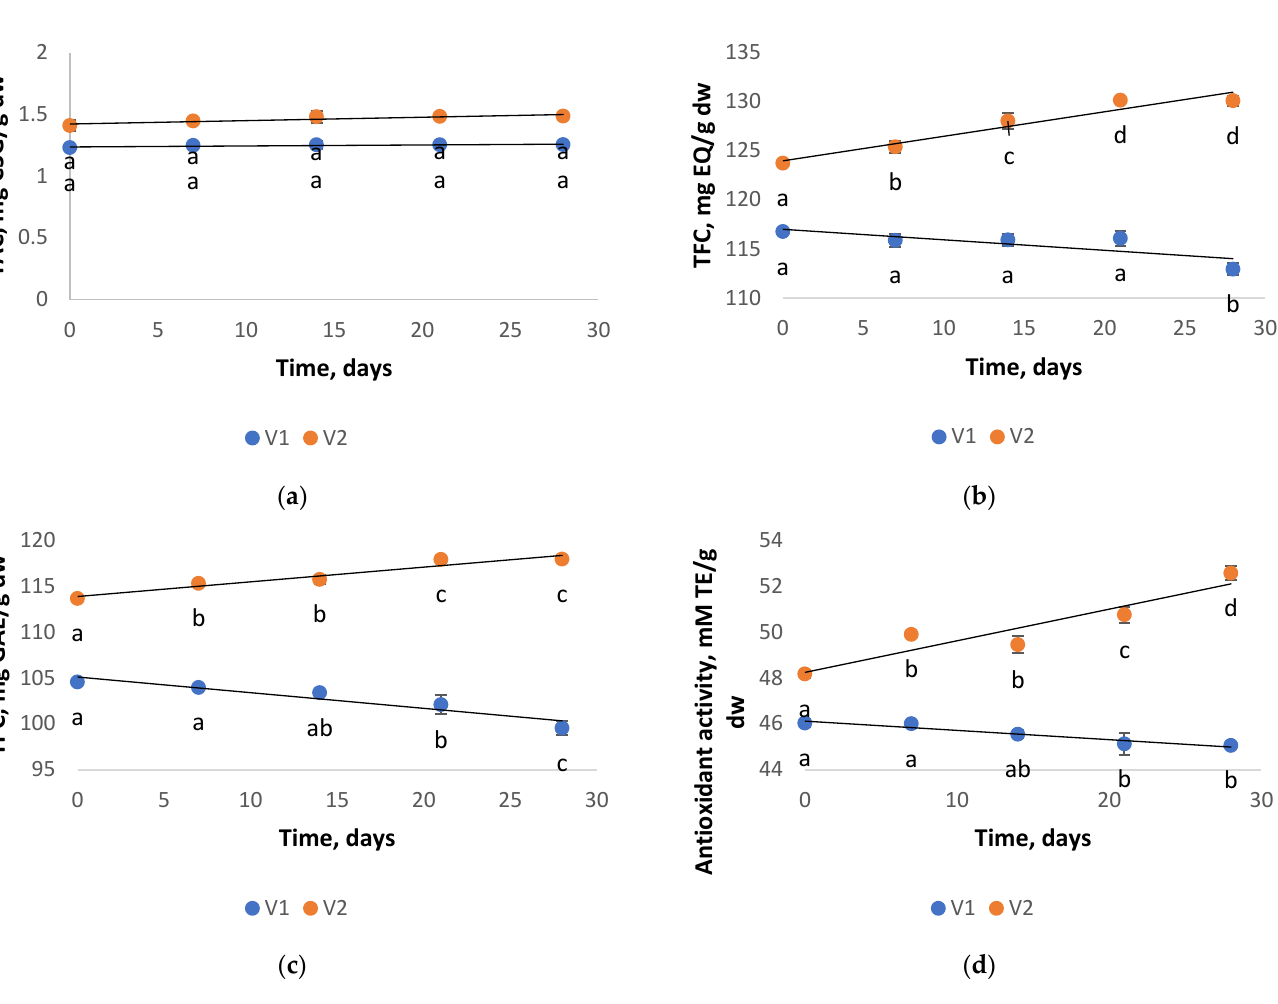
Figure 3. The TAC ( a ), TFC ( b ), TPC ( c ), and antioxidant activity ( d ) stability of the V1 and V2 powders after 28 days of storage at 5 °C. For each tested phytochemical and storage time of the powder variant, values sharing different letters indicate a significant difference, p < 0.05.